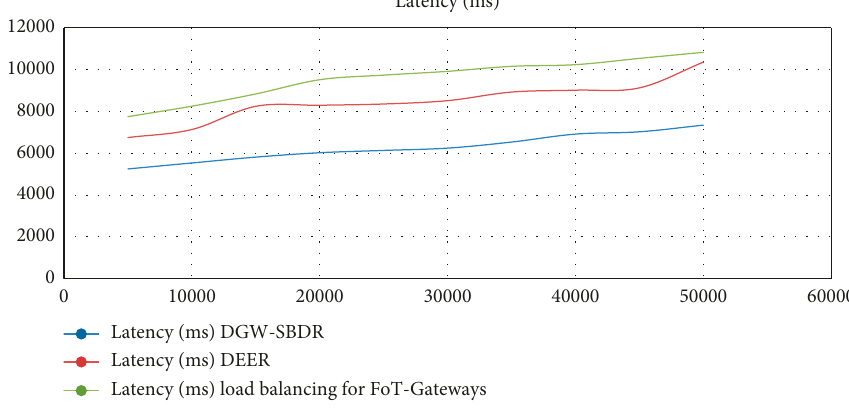
Figure 6: Average latency of various tasks.